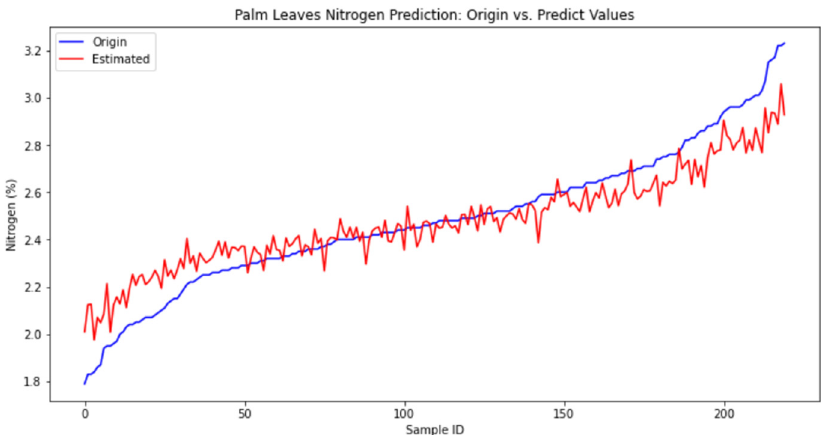
Figure 7. Line graph RFR model prediction: Origin vs. Estimated Values, with data sorted by the origin value of increasing order in the x axis.